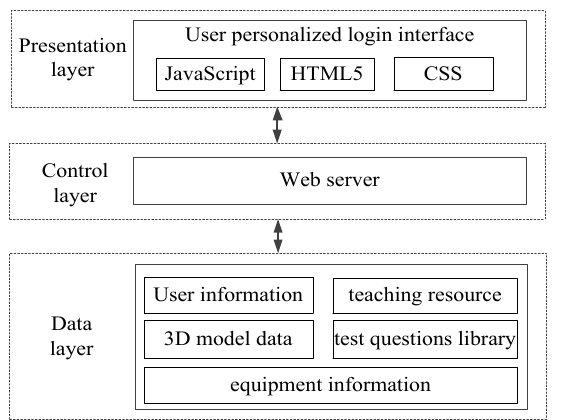
Figure 1. System architecture